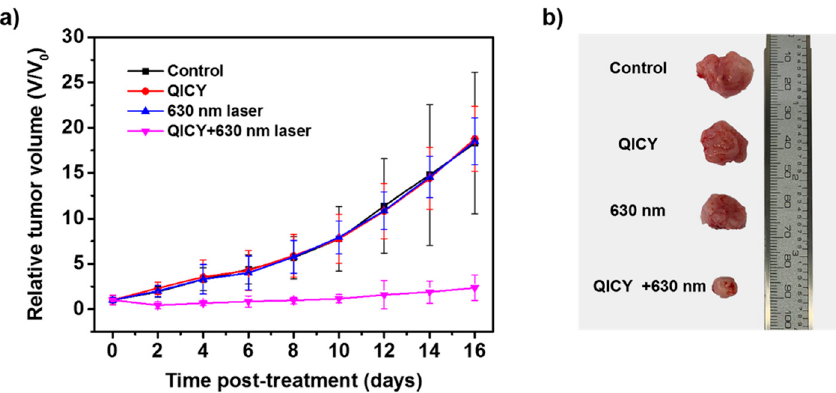
Figure 9. In vivo fluorescence imaging of 4T1 tumor-bearing BALB/c mice after the intravenous injection of QICY at the concentration of 400 μ M, Ex. = 630 nm/Em. = 700 nm.